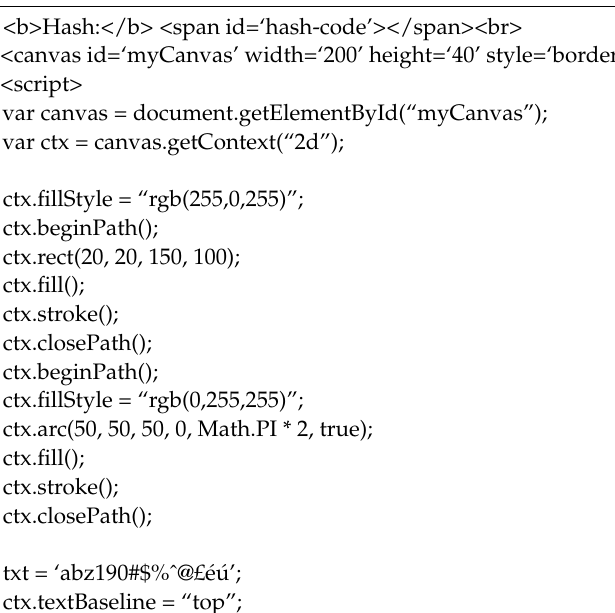
Algorithm 1 How the canvas fingerprint is being